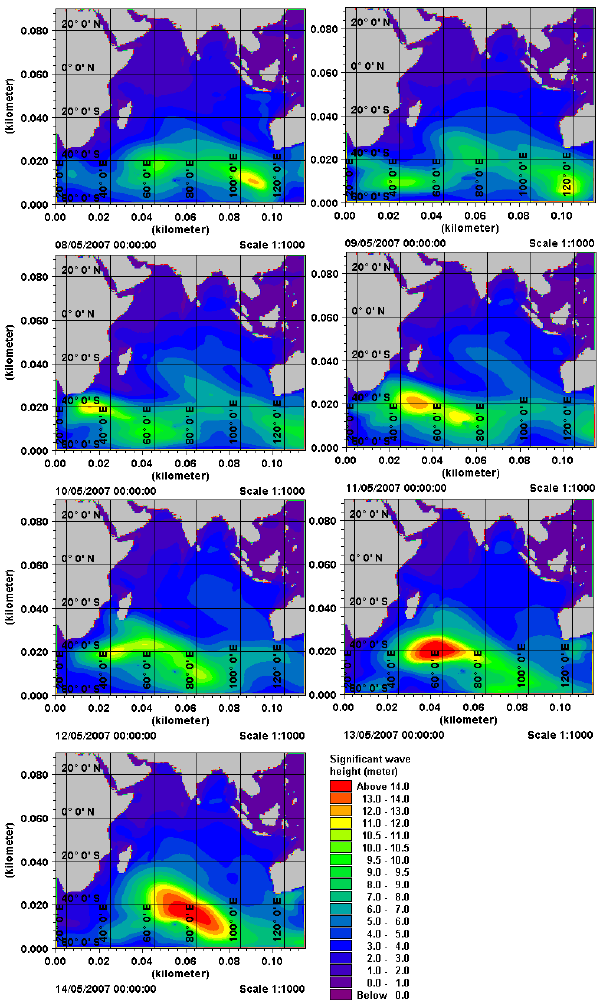
Fig. 5. Propagation of swells during May 2007 in the north Indian Ocean (WW III model).